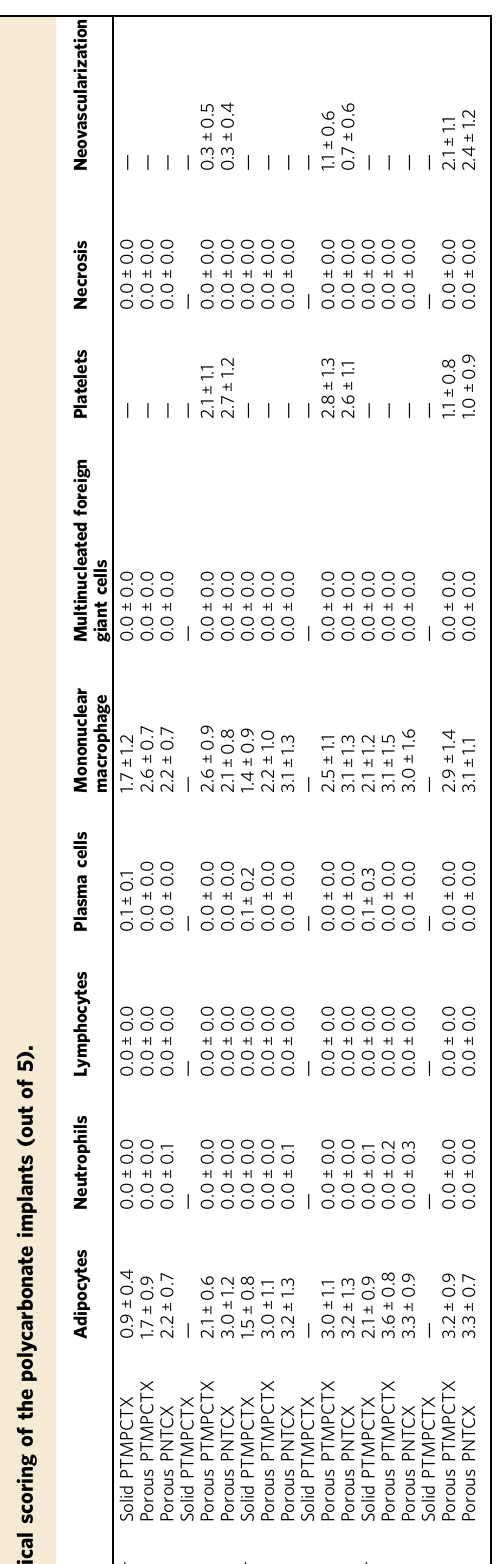
Synthesis of aliphatic polycarbonate . Ring opening polymerization of the cyclic monomers was used to obtain oligomers. To an open round bottom fl ask, CHCl 3 and cyclic monomer(s) were added followed by 1,8-diazabicyclo[5.4.0]undec-7-ene (DBU). For PolyTMPAC, TMPAC (100g, 500.0 mmol) was dissolved in 100